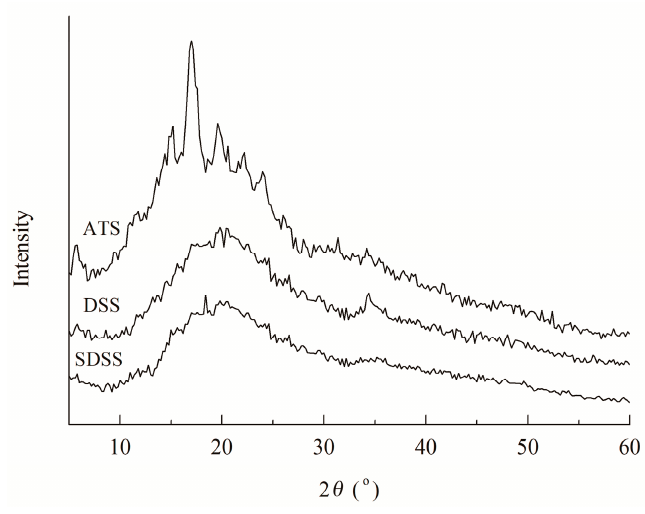
Figure 2. X-ray diffraction of ATS, DSS and SDSS films.